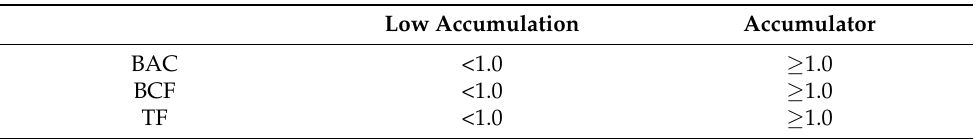
Table 3. Phytoremediation potential of plants based on BAC, BCF, and TF according to Ghazaryan et al.